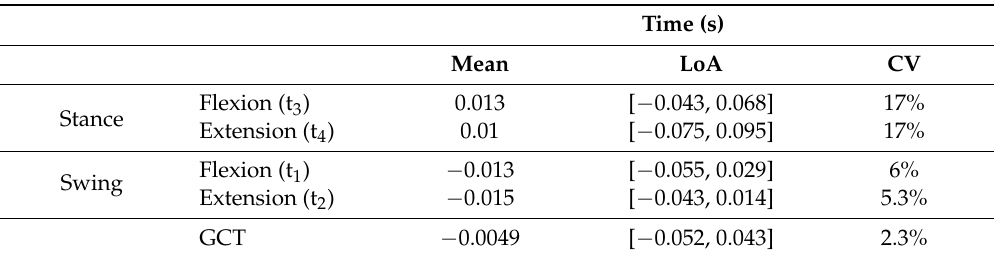
Table 1. Bland–Altman Analysis Comparing Interval Times of MAPR and OMCS KAV during Flexion and Extension in Stance and Swing.